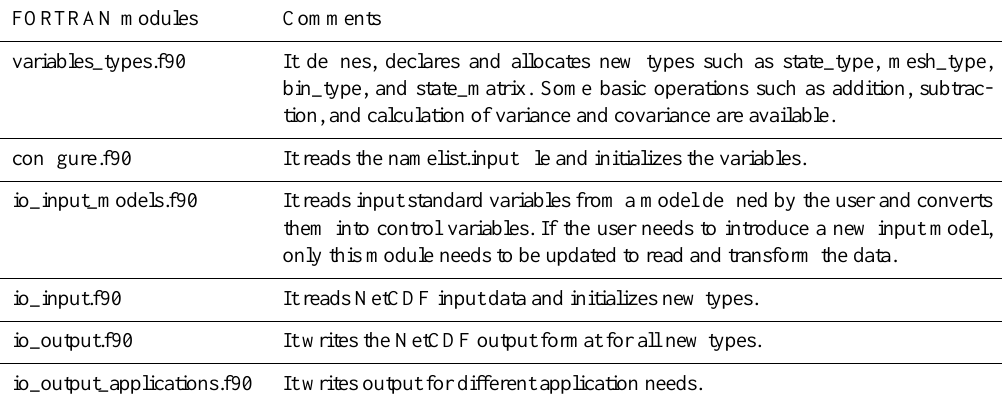
Table A1. FORTRAN code description of the GEN_BE v2.0